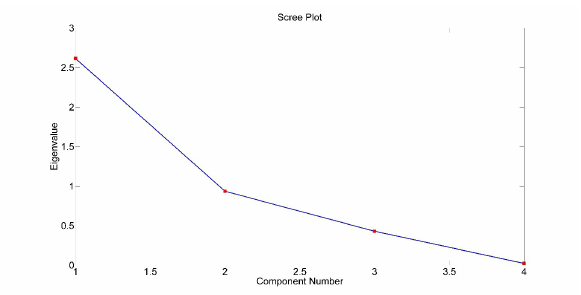
Figure 4: Scree plot of the FA